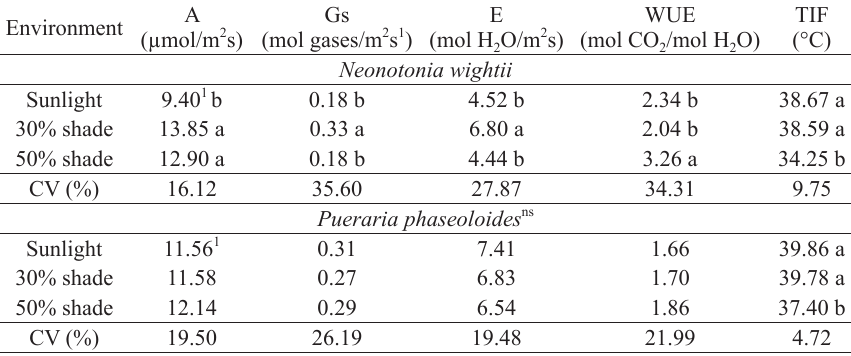
Photosynthetic rate (A), stomatal conductance (Gs), transpiration (E), water-use efficiency (EUA), and internal temperature of leaflets (TIF) of Neonotonia wightii and Pueraria phaseoloides cultivated under different light